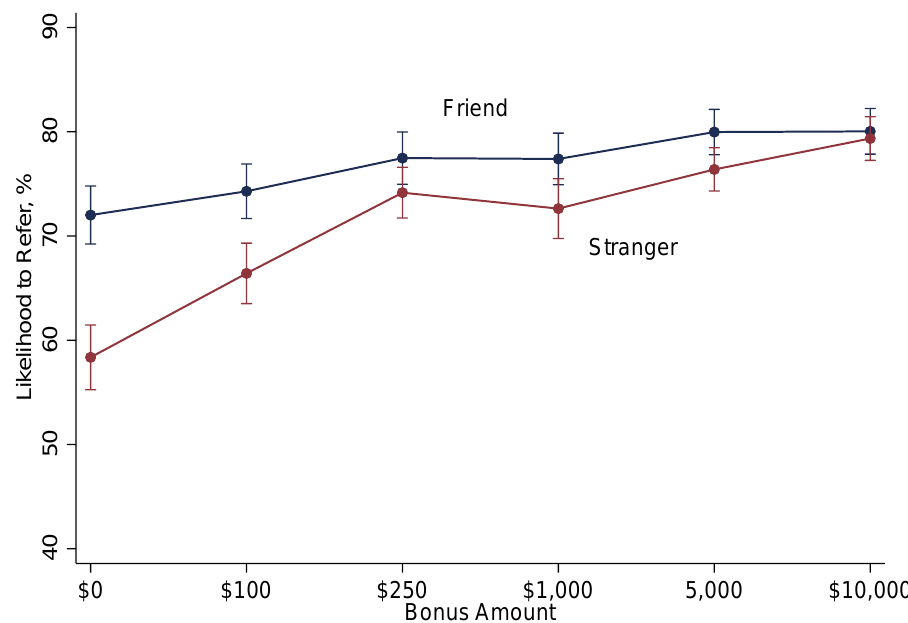
Figure 2: Referral patterns for strangers approach that of friends given (higher)